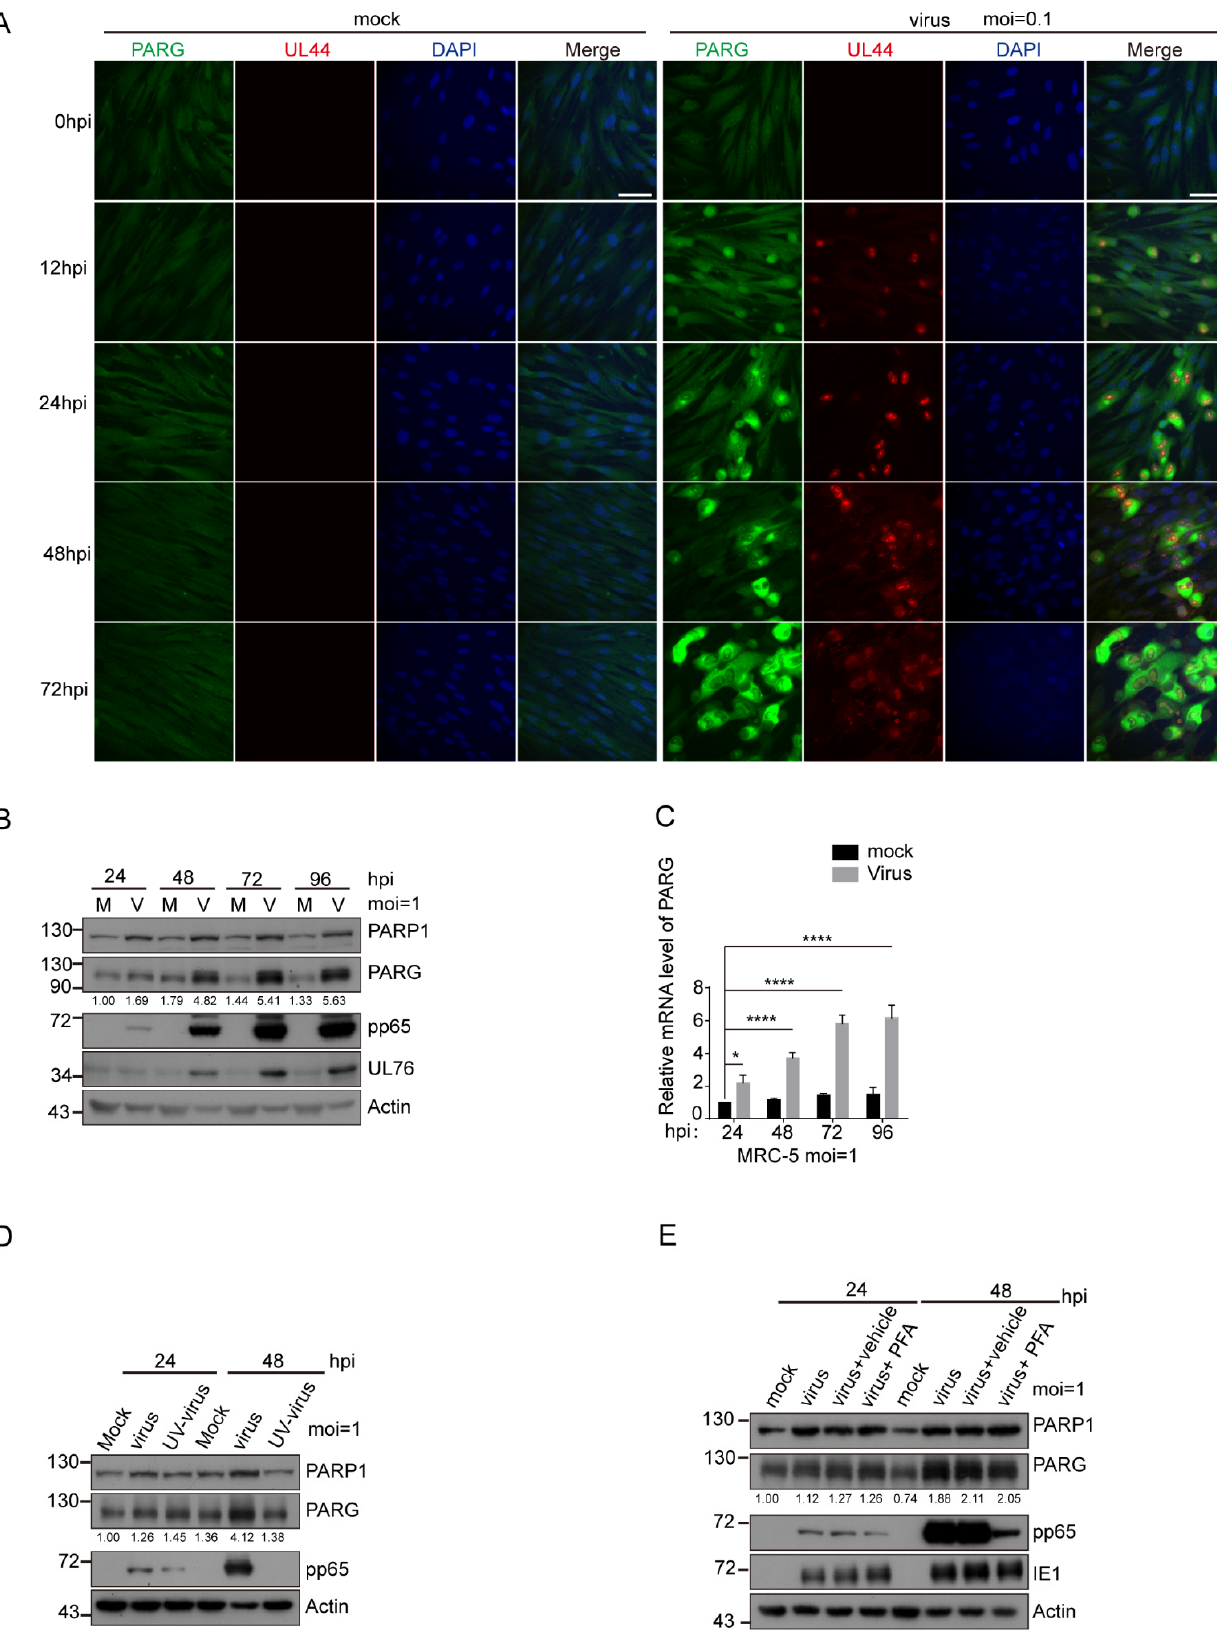
Figure 3. PARG is continuously upregulated over the course of HCMV infection. ( A ) The expression profiles of PARG and HCMV UL44 in HCMV-infected MRC-5 cells were analyzed by IFA. MRC-5